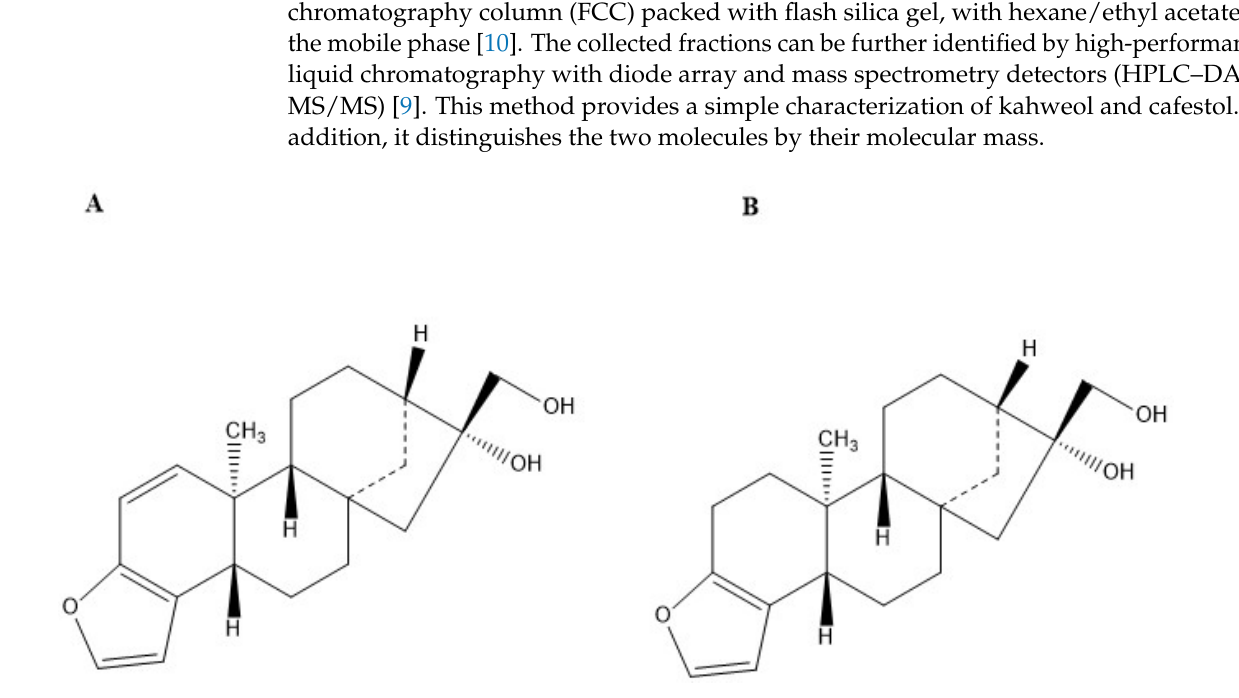
Figure 1. Chemical structure of ( A ) Kahweol and ( B ) Cafestol, created by ChemDraw. In unfiltered coffee, such as Turkish coffee or espresso, kahweol and cafestol are found in relatively higher concentrations in comparison to filtered and instant coffee. A study performed on healthy ileostomy volunteers showed that, upon coffee consumption, gastric juices break down nearly 30% of kahweol and cafestol, and 64–70% of cafestol and 70–73% of kahweol are absorbed in the small intestine, with minute amounts of glucuronidated or sulphated conjugate forms being excreted in the urine [11]. As only about 1% or less of conjugate cafestol and kahweol is excreted in the urine, the two diterpenes are likely metabolised further in the body, and there is evidence that cafestol circulates in the liver and gastrointestinal tract, exerting its effects [12].